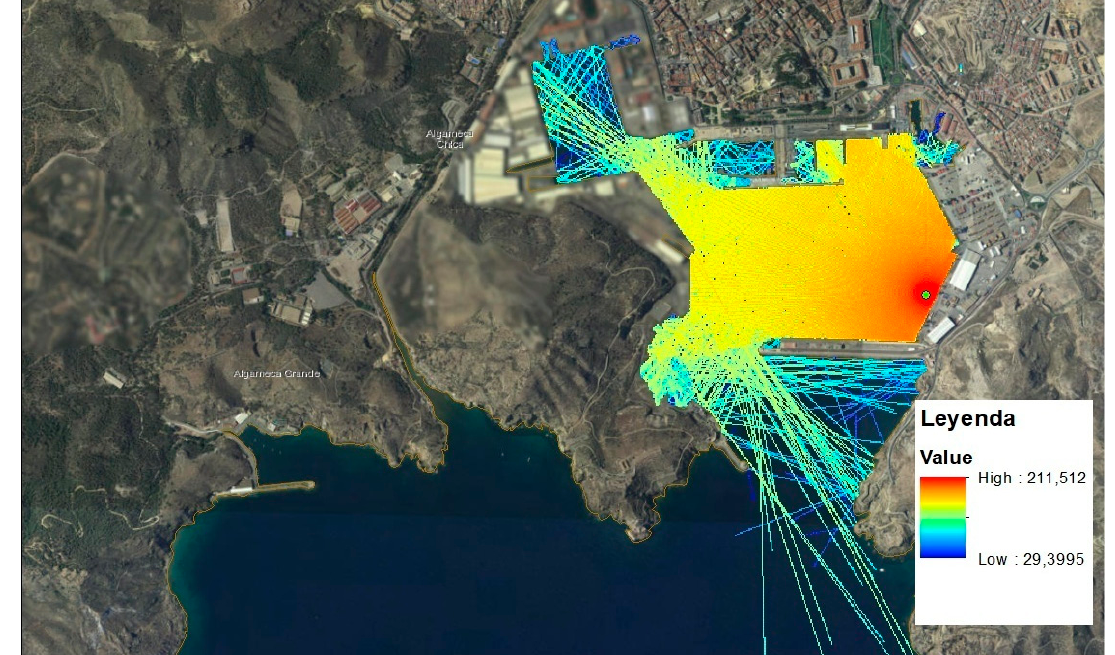
Figure 13. Example of submarine acoustic propagation by the web tool.